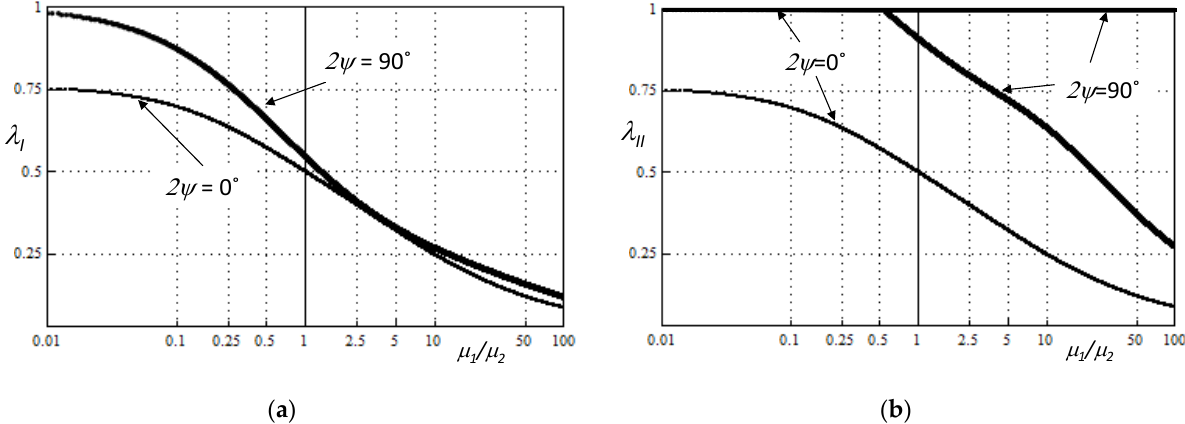
Figure 2. A solution of eigenequations ( ν 1 = ν 2 = 0.3, plane stress condition), ( a ) for Mode I (7), ( b ) for Mode II (8).